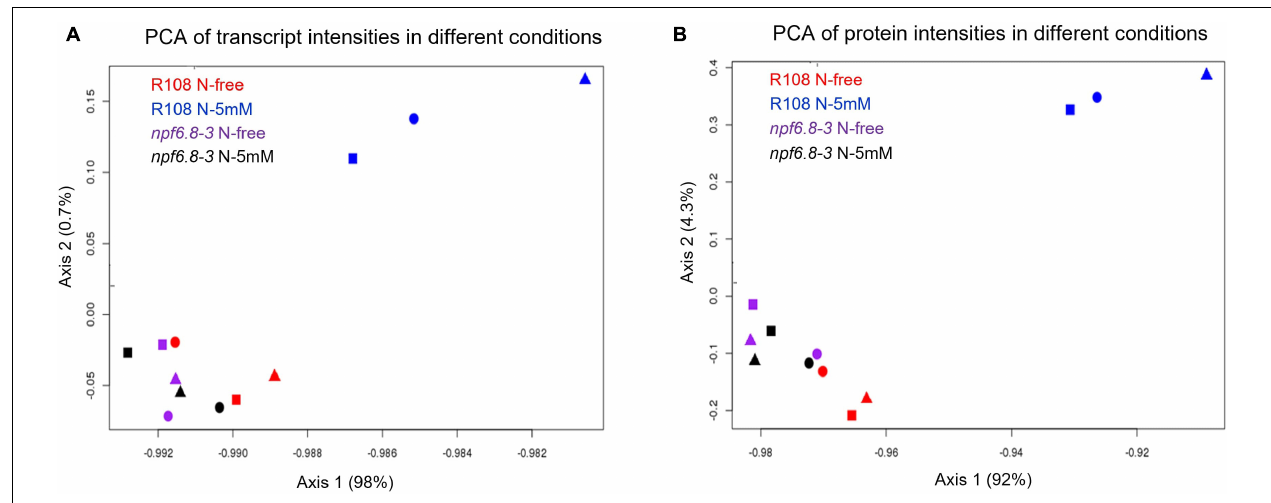
FIGURE 2 | Principal component analysis of transcriptomic and proteomic data. Values of transcripts (A) or proteins (B) from each biological replicate under the four different conditions are projected onto the first two principal components (Axis 1 and Axis 2). Square, round and triangle correspond to the three independent